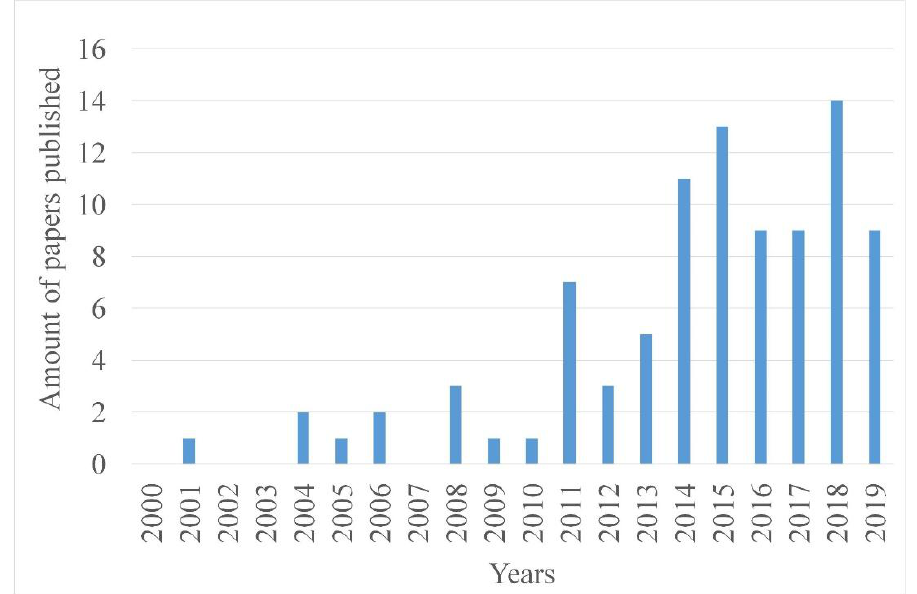
Figure 4. Number of papers about artificial neural network (ANN) forecasting methods based on year of publication.